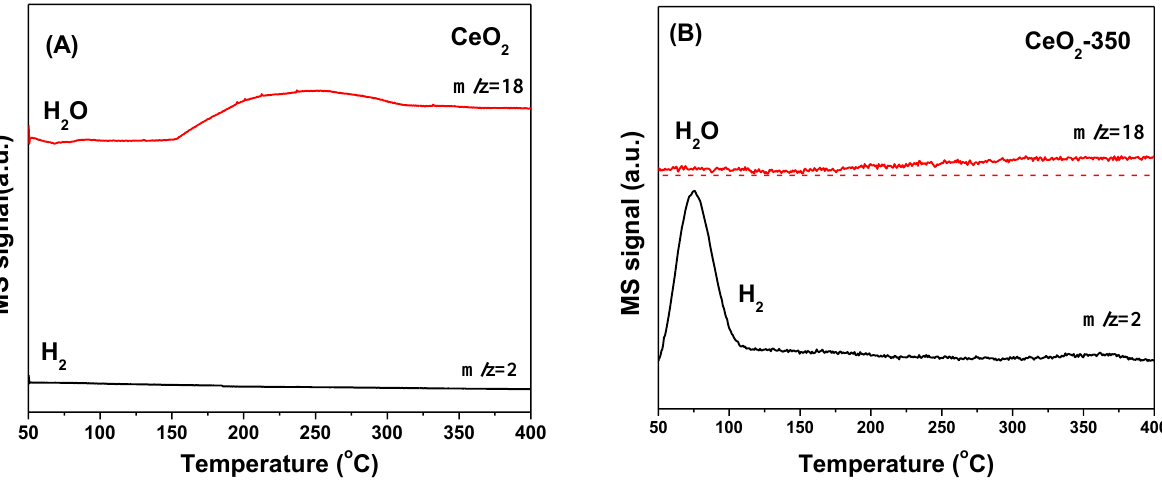
Figure 9. H 2 -TPD-MS profiles of ( A ) unreduced CeO 2 (CeO 2 ) and ( B ) reduced CeO 2 (CeO 2 -350) samples.